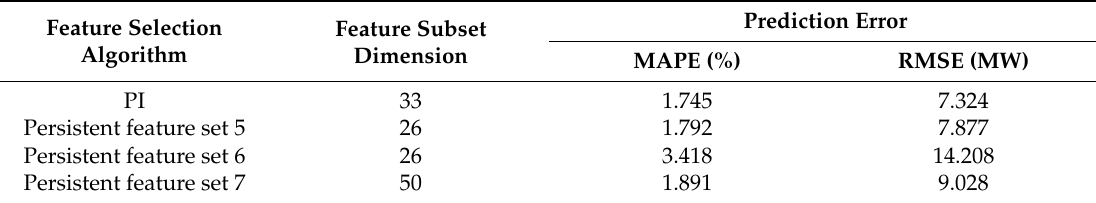
Table 9. Comparison of permutation importance (PI) and three empirical feature selection algorithms when day-ahead prediction is